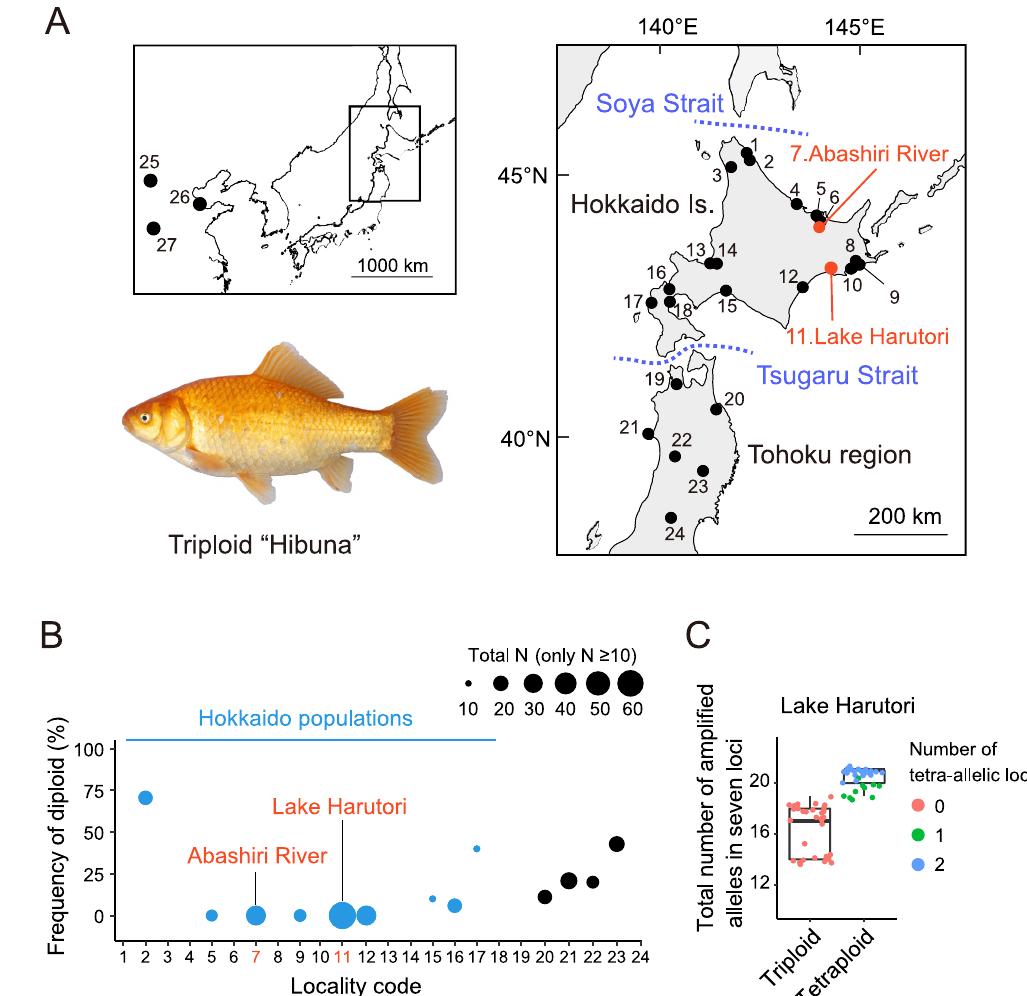
Fig 1. Sampling sites and estimated ploidy. (A) Sampling sites of the scarlet body color variants of C . auratus -complex, Hibuna (#7 and #11), and previously analyzed specimens reused in this study [11]. The map was generated from the R package mapdata [35]. (B) Frequency of diploids in each locality. Localities with a total number of specimens � 10 are shown. The size of each point indicates sample size and Hokkaido populations are colored blue. (C) The total number of amplified alleles in seven microsatellite loci from triploid and tetraploid individuals in Lake Harutori. Each point indicates each specimen with color corresponding to the number of tetra-allelic loci.